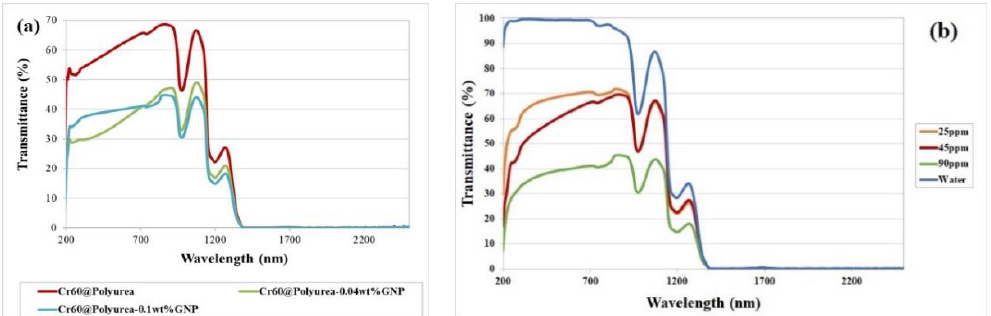
Figure 8. Transmittance spectra of ( a ) Cr60@polyurea, Cr60@polyurea-0.1 wt%GNP, and Cr60@polyurea-0.04 wt%GNP slurries at 45 ppm concentration; ( b ) slurries of water and Cr60@polyurea-0.1 wt%GNP with different concentrations.